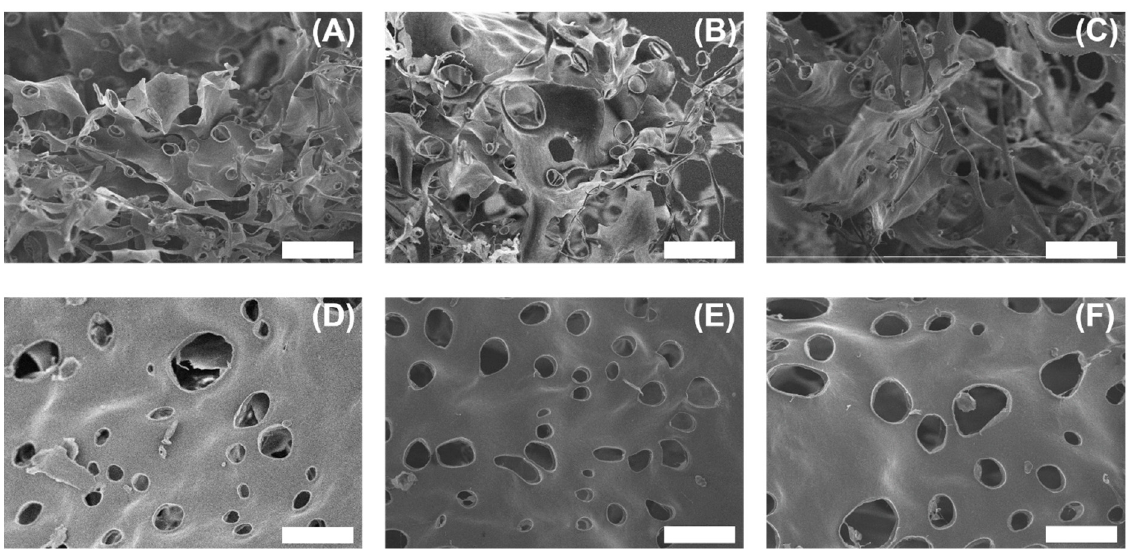
Figure 7. SEM Micrographs of freeze-fractured R-4VBC* ( A , D ); B-4VBC* ( B , E ); and P-4VBC* hydro- gels ( C , F ), taken from the centre of hydrogel cross-section ( A , B , C ) and edge of cross-section ( D , E , F ). All ccale bars 100 µm.